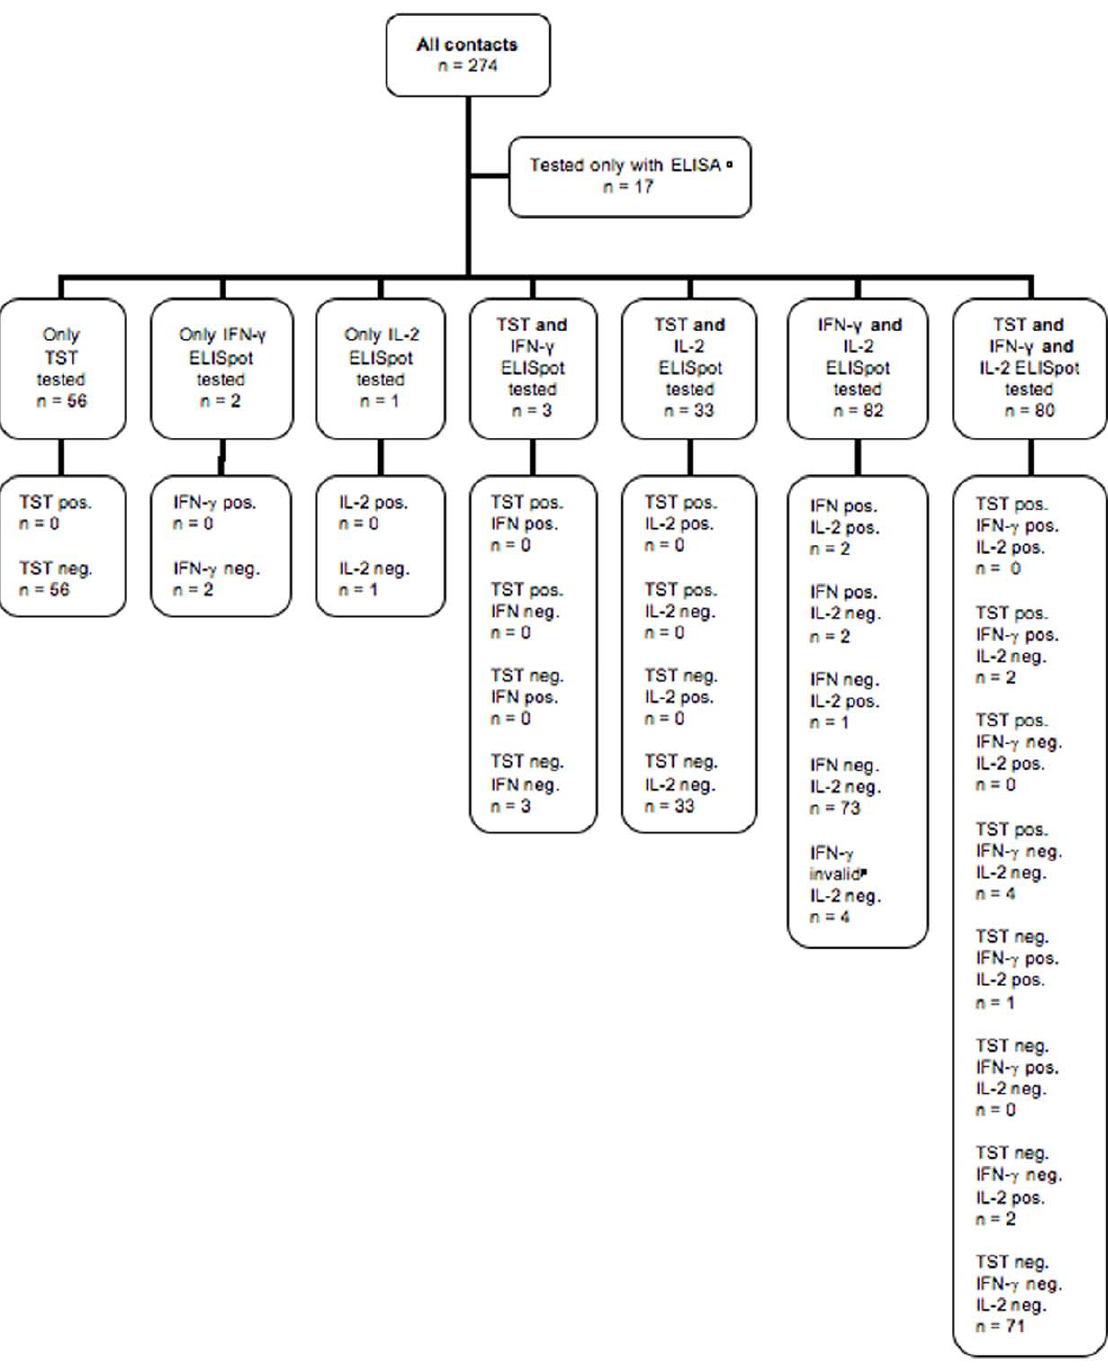
Figure 2. Distribution of immunodiagnostic test results. TST: tuberculin skin test; ELISpot: enzyme-linked immunospot. D In these 17 cases a skin test could not be performed. Because we did not obtain their informed consent for participation, these individuals were not tested with ELISpot in the study but tested by the city’s health authorities with ELISA ( QuantiFERON-TB Gold ). $ These 2 contacts did not receive IL-2 ELISpot testing because they had only agreed on testing with test methods already approved by the health authorities. We performed IFN- c ELISpot here. 1 In this case the amount of blood taken from the student was not sufficient to perform both ELISpot tests. This contact later received ELISA testing from the city’s health authorities, in which she showed a negative result. * These 3 contacts or their parents did not agree on IL-2 ELISpot testing but only on test methods already approved by the health authorities. # These 4 contacts showed an indeterminate IFN- c ELISpot result. Because skin testing could not be performed, the city’s health authorities then tested these 4 with ELISA, in which all of them showed a negative